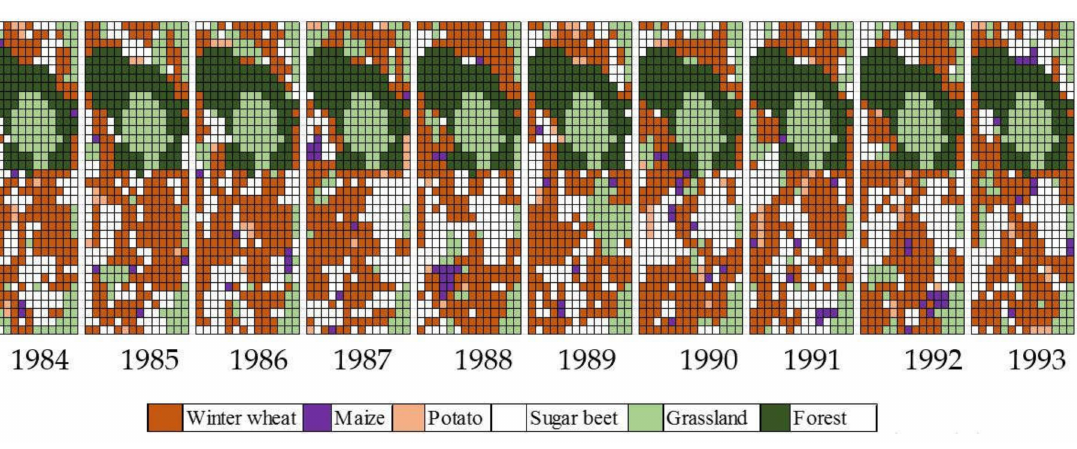
Figure 4. Land use from 1984 to 1993.